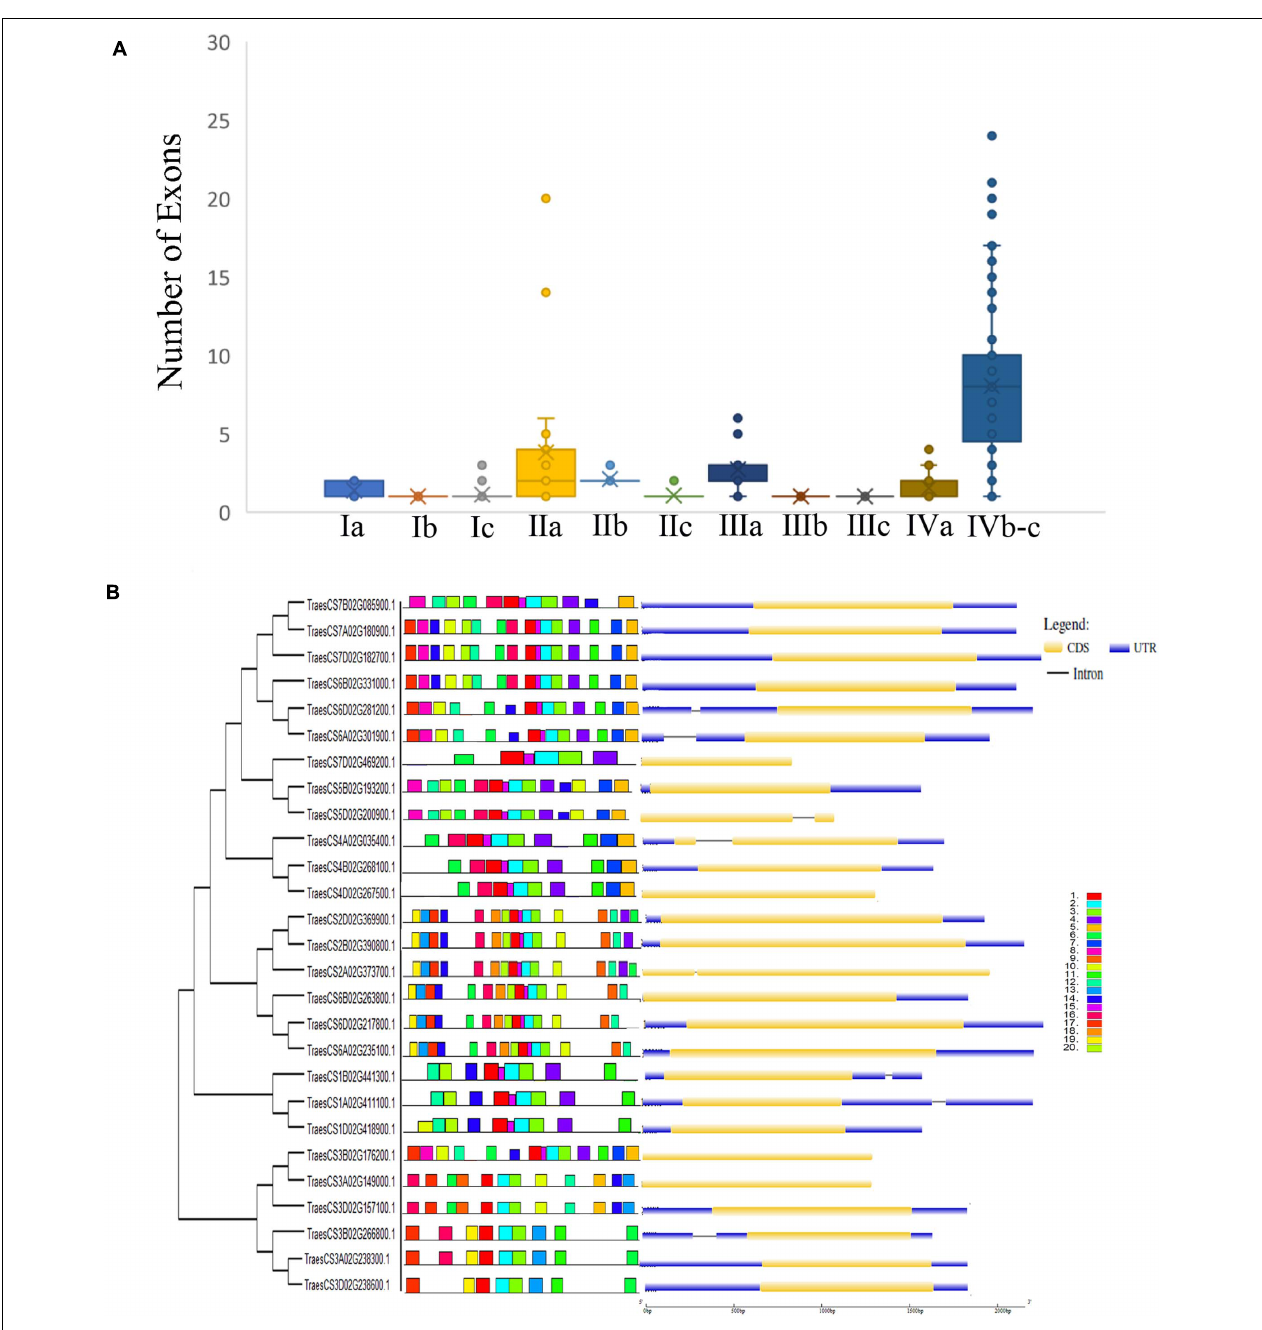
FIGURE 4 | Distribution of numbers of exons, conserved motifs and Gene structure and of TaAP2/ERF genes in Wheat. (A) Presence of different numbers of Exons in different groups of TaAP2/ERF gene family in Wheat. (B) Phylogenetic relationship, conserved motifs located on each gene with the relative combined p -value and gene structure of Wheat TaAP2/ERF